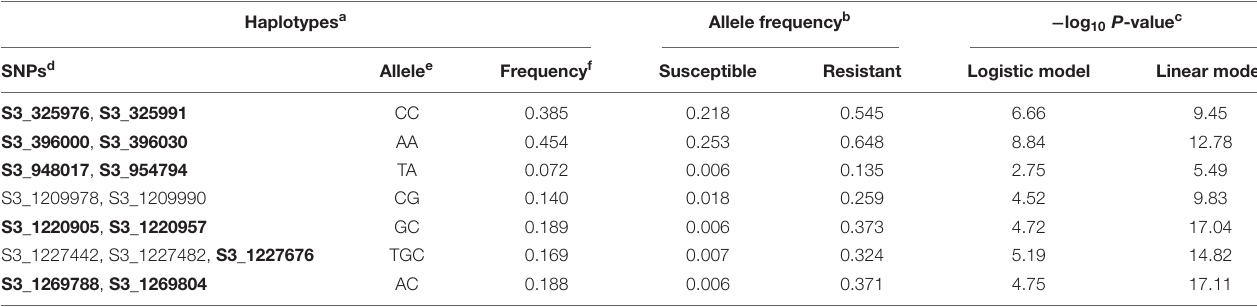
TABLE 3 | Haplotype-based association analysis at the race 13 of P. effusa resistance loci in spinach association panel comprising breeding populations from a cross of race 13 resistant cultivars Swan, squirrel, Tonga, T-Bird with susceptible cultivars Whale and Polka. Haplotypes a Allele frequency b − log 10 P -value c